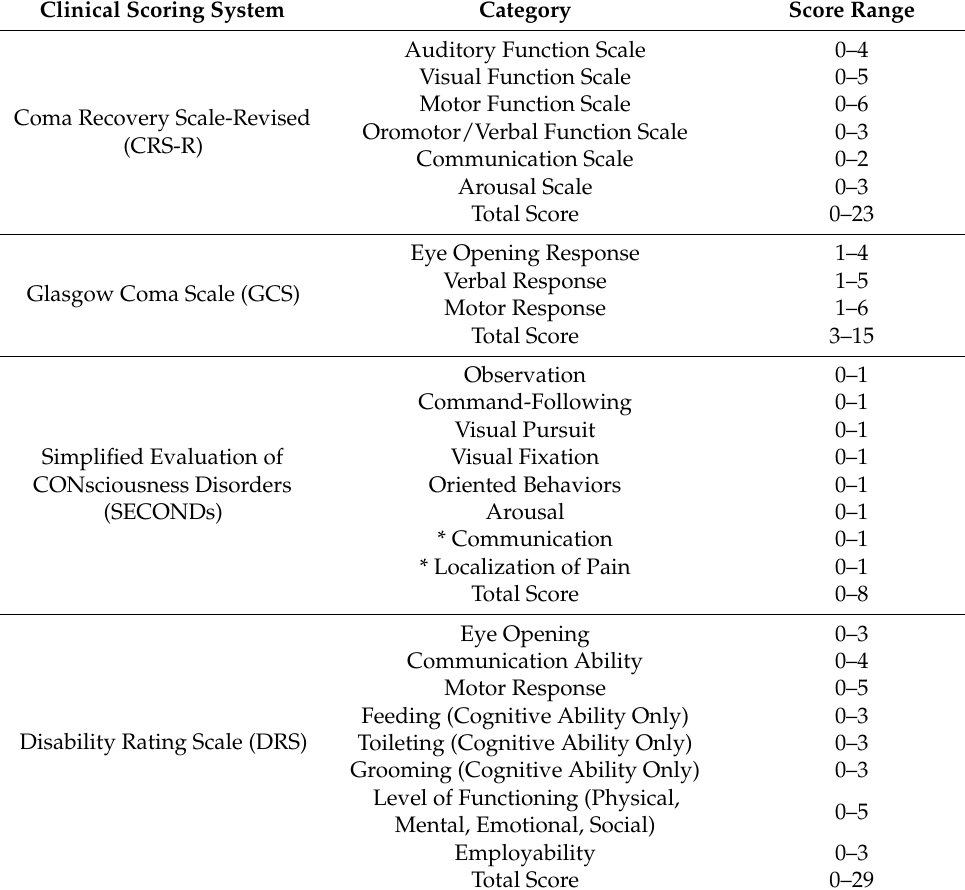
Table 2. Select clinical scoring systems for determining levels of consciousness and